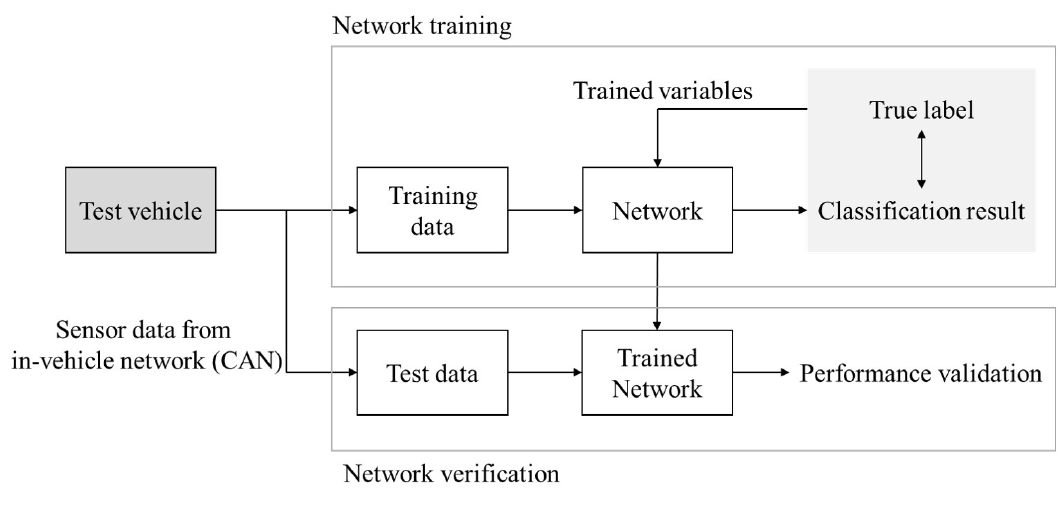
Figure 8. Experiment and learning